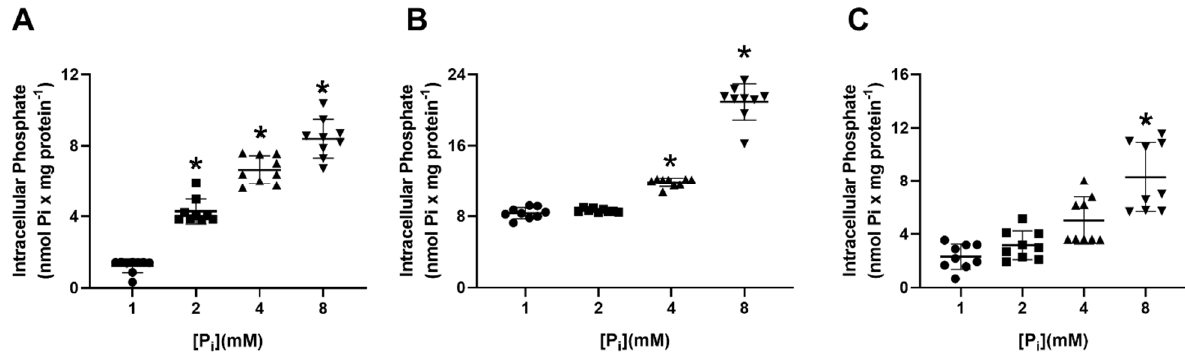
Figure 2. Effect of inorganic phosphate concentrations on total intracellular Pi in breast cell lines. Different breast cell lines: MCF10-A (blank bars) ( A ), MCF-7 (grey bars) ( B ), and MDA-MB-231 (dark grey bars) ( C ) were treated with various Pi concentrations (1, 2, 4 or 8 mM Pi) for 24 h and total intracellular Pi concentrations were determined, as described in Section 4. Bars represent mean ± SE of at least three independent biological samples. * p < 0.05 indicates changes were significantly different, as assessed by ANOVA followed by Tukey’s multiple comparison test.